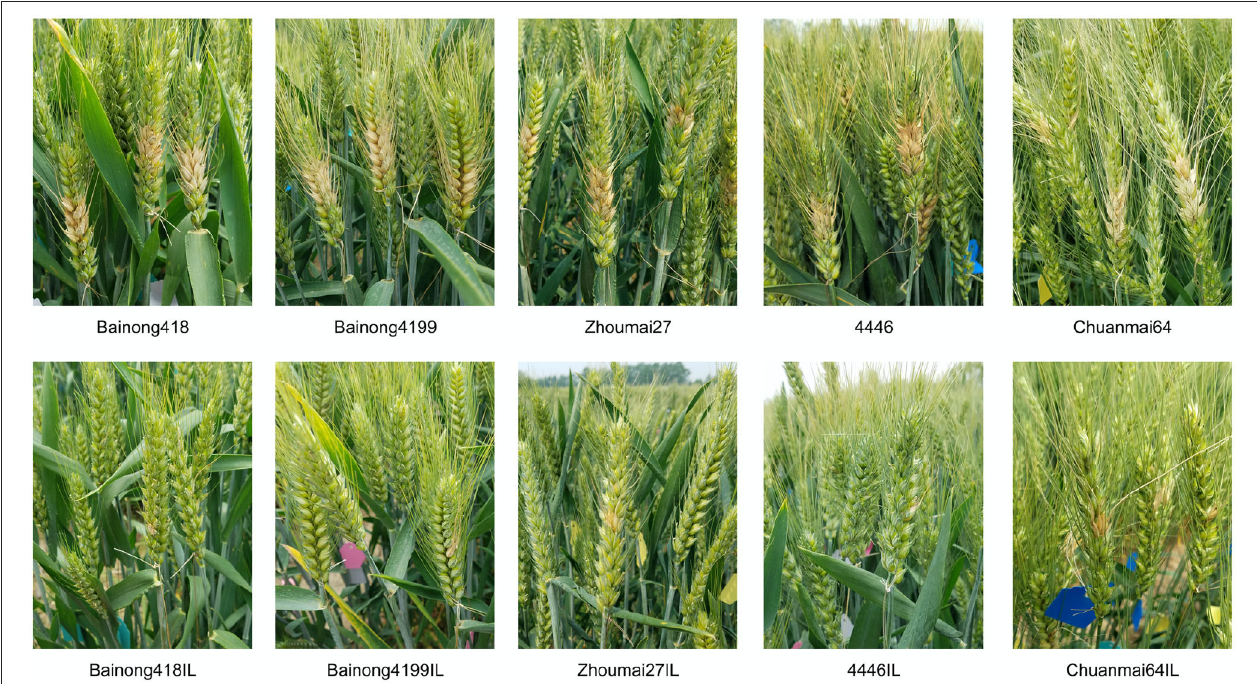
FIGURE 3 | Fusarium head blight (FHB) symptom illustration of the recipients (top) and Fhb1 , Fhb4 , and Fhb5 introgression lines (bottom). Photos were taken 18 days after single floret inoculation.